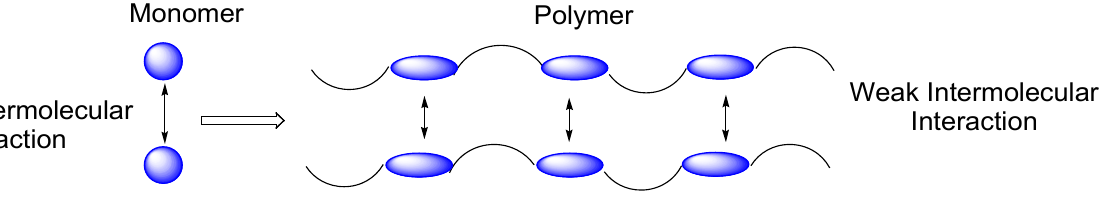
Figure 7. Decrease in intermolecular interaction due to polymerization [24].